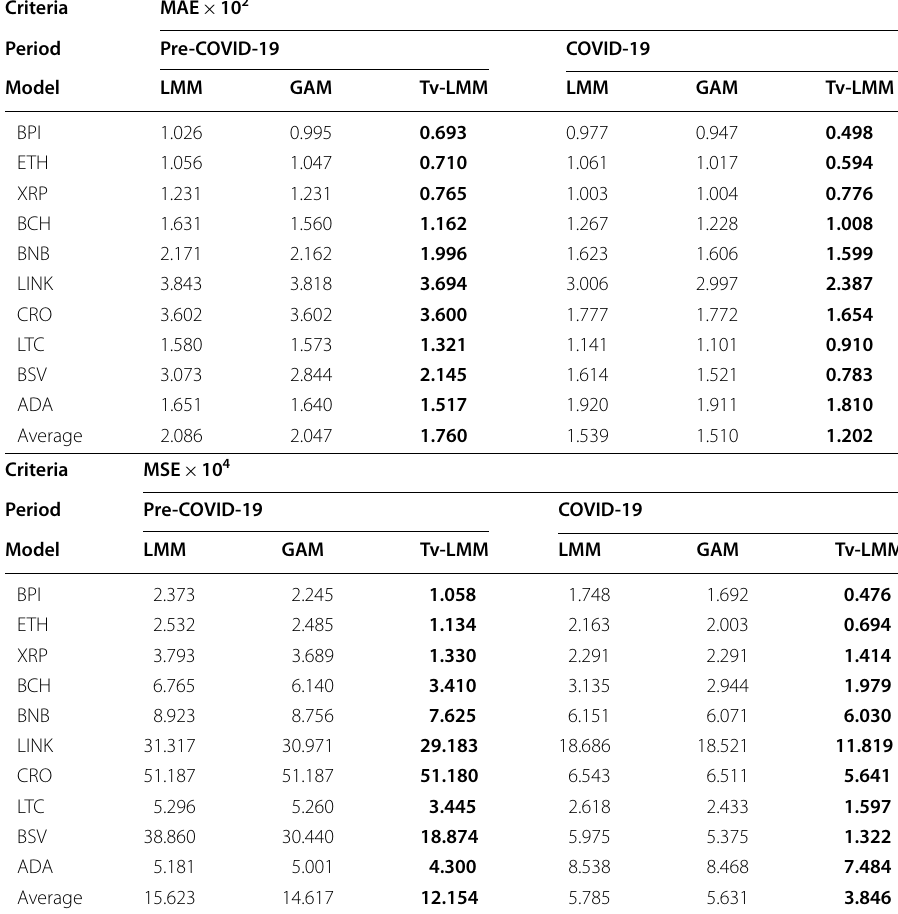
Bold values indicate the best modeling performance for cryptocurrency price in terms of the lowest MAE and MSE, respectively